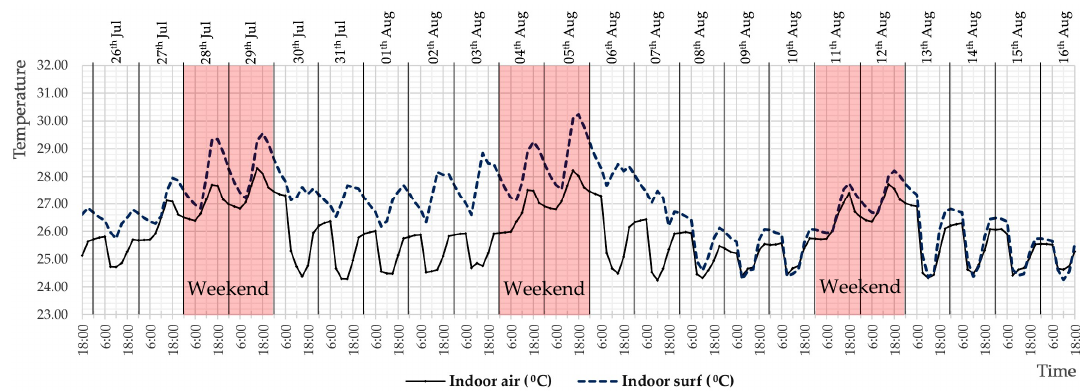
Figure 10 . Wall surface and indoor air temperature behavior in Building “A”